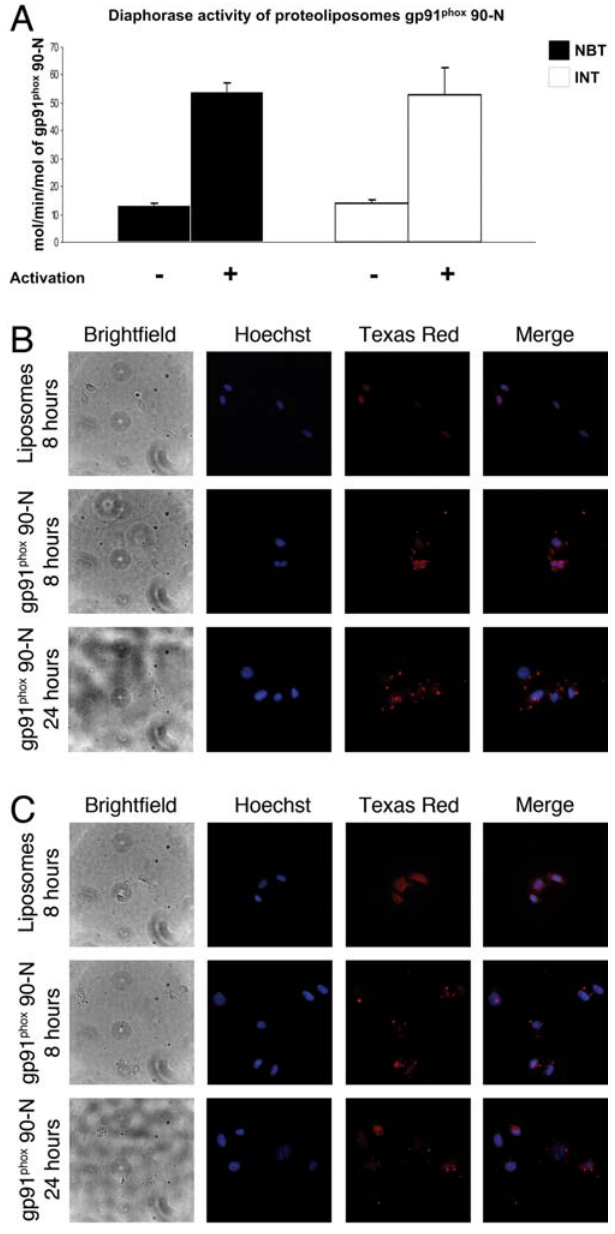
Figure 6. gp91 phox 90-N proteoliposomes. (A) Diaphorase assay of purified proteoliposomes gp91phox 90-N using NBT or INT as electron acceptor, n $ 2. Cellular uptake of gp91 phox 90-N proteins delivered with proteoliposomes in HeLa cells after 8 or 24 hours of incubation. The proteins were detected by fluorescence microscopy using a monoclonal anti-his antibody (B) or a monoclonal anti-gp91 phox antibody (C).